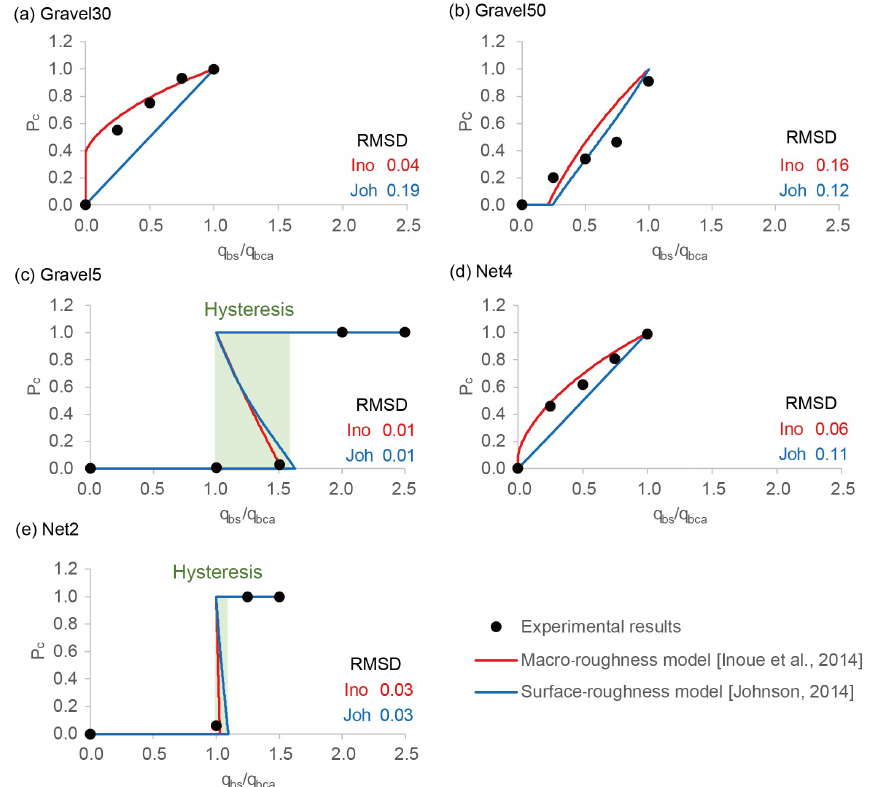
Figure 11. Comparison of our experimental results with roughness models by Inoue et al. (2014) and Johnson (2014). The r br for the surface-roughness model and the ϕ for the exponential model are adjusted to minimize RMSD of the alluvial cover (see Table 2). Note that there is no adjustment of k sb in the macro-roughness